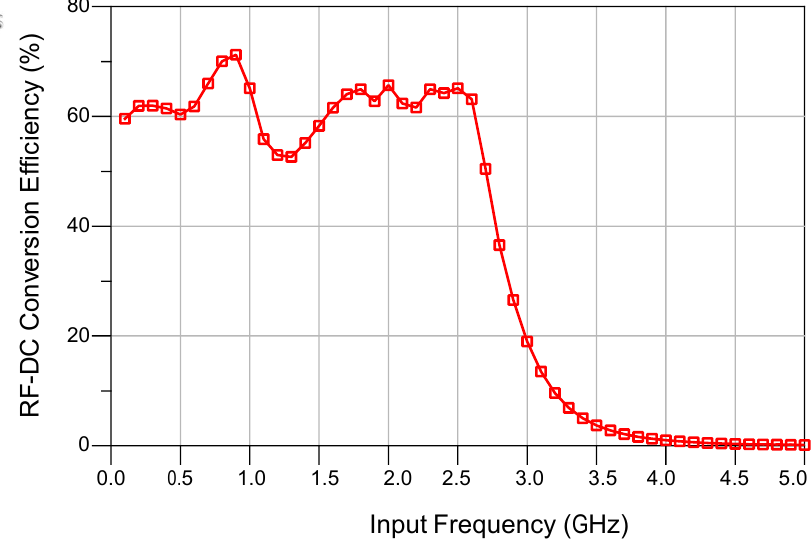
Figure 16. RF-DC conversion efficiency vs. the input frequency of the proposed quad-band circuit with four receiving antennas for the load of 5 k Ω